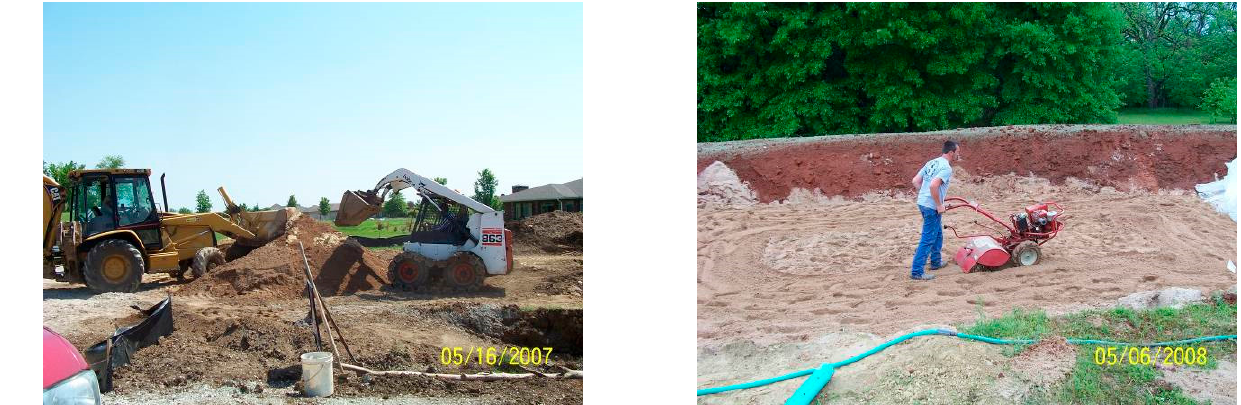
Figure 4. Mixing fly ash; ( left ) by front end loaders, ( right ) by rototiller.